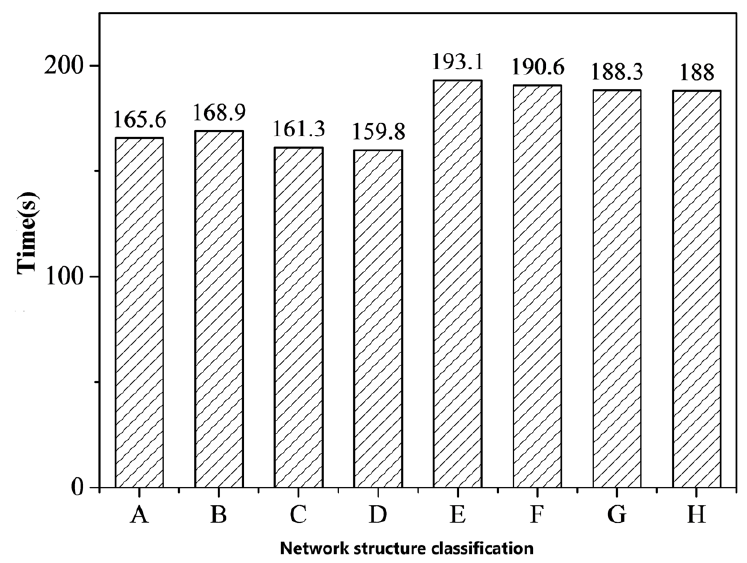
Figure 9. Time spent by each network after 30 trainings.